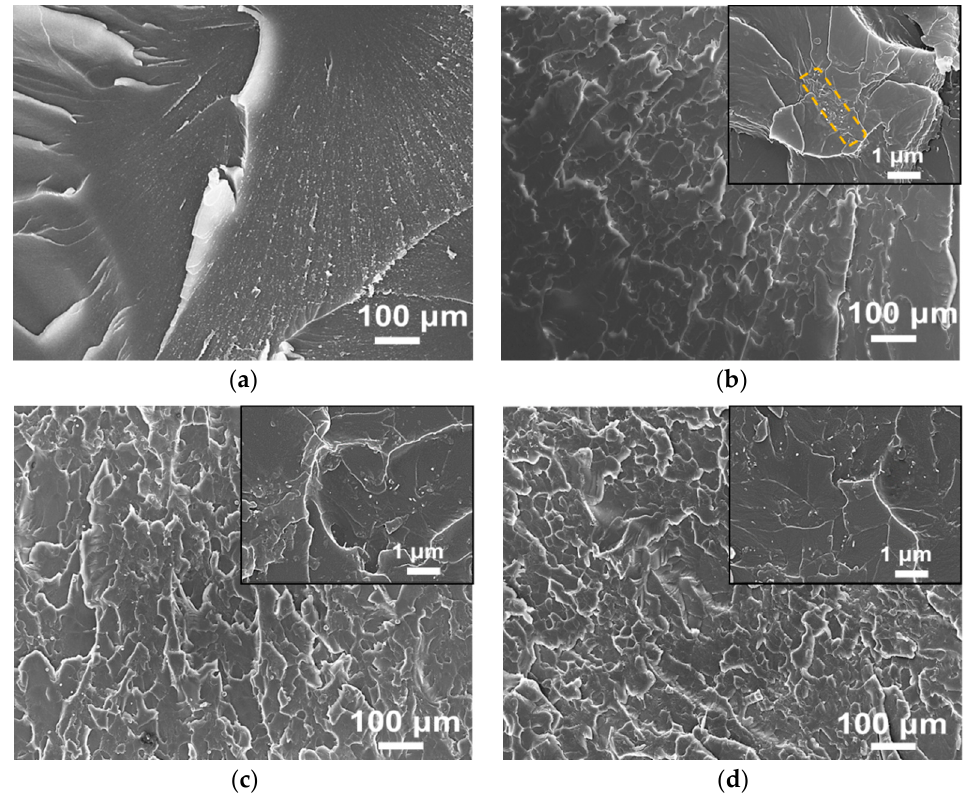
Figure 11. Scanning electron microscope (SEM) micrographs of fracture surface: ( a ) neat epoxy, ( b ) MWCNT-NH 2 /epoxy, ( c ) MWCNT-BuGE/epoxy and ( d ) MWCNT-BeGE/epoxy. Inset, high-magnification micrographs of dispersed MWCNTs in epoxy